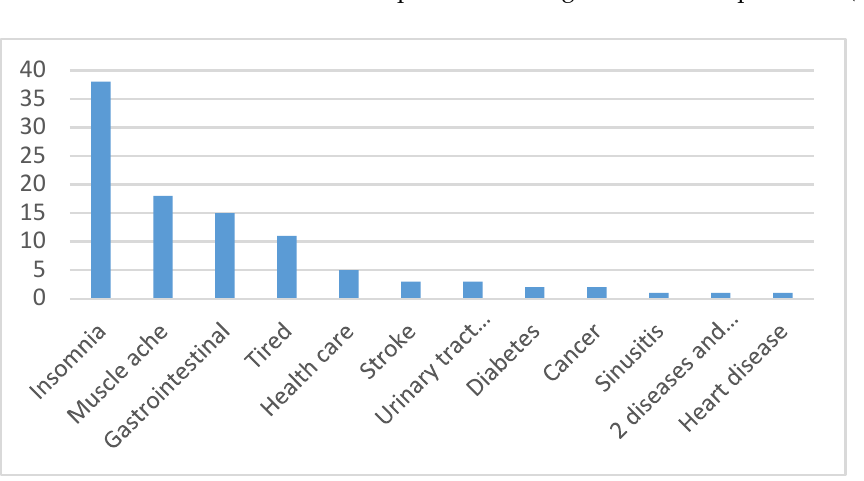
Table 3. Musculoskeletal status of reflexologists.